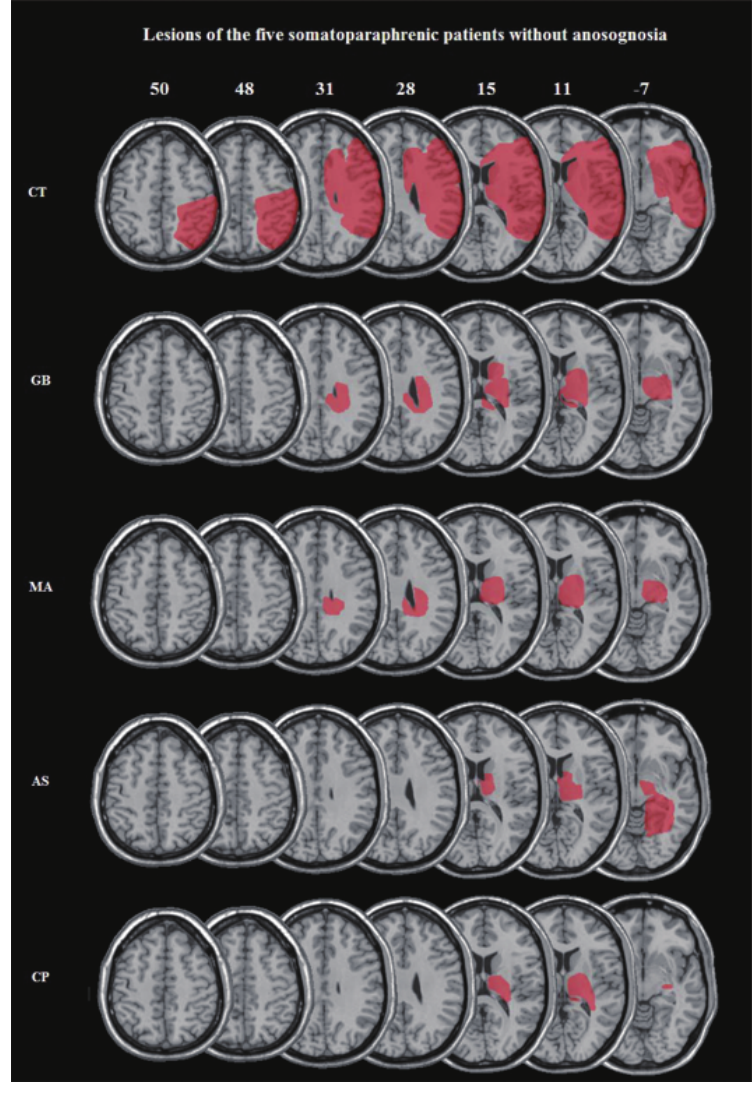
Fig. 1. C.T. scans of the fi ve patients with somatoparaphrenia without anosognosia for